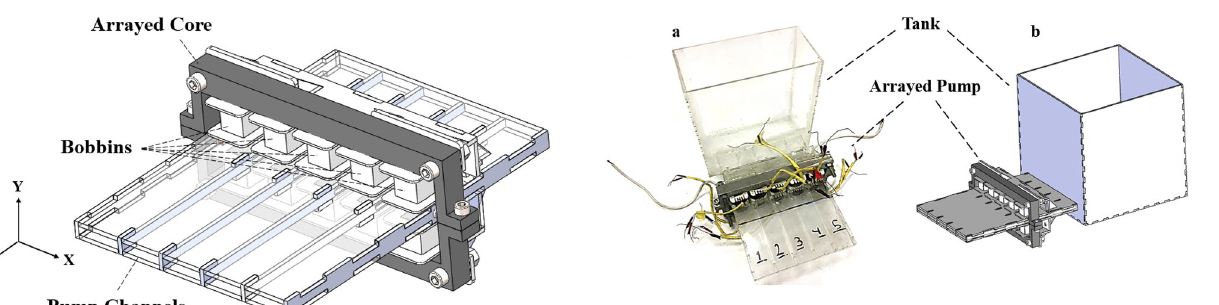
Fig. 3 The assembled view of the pump